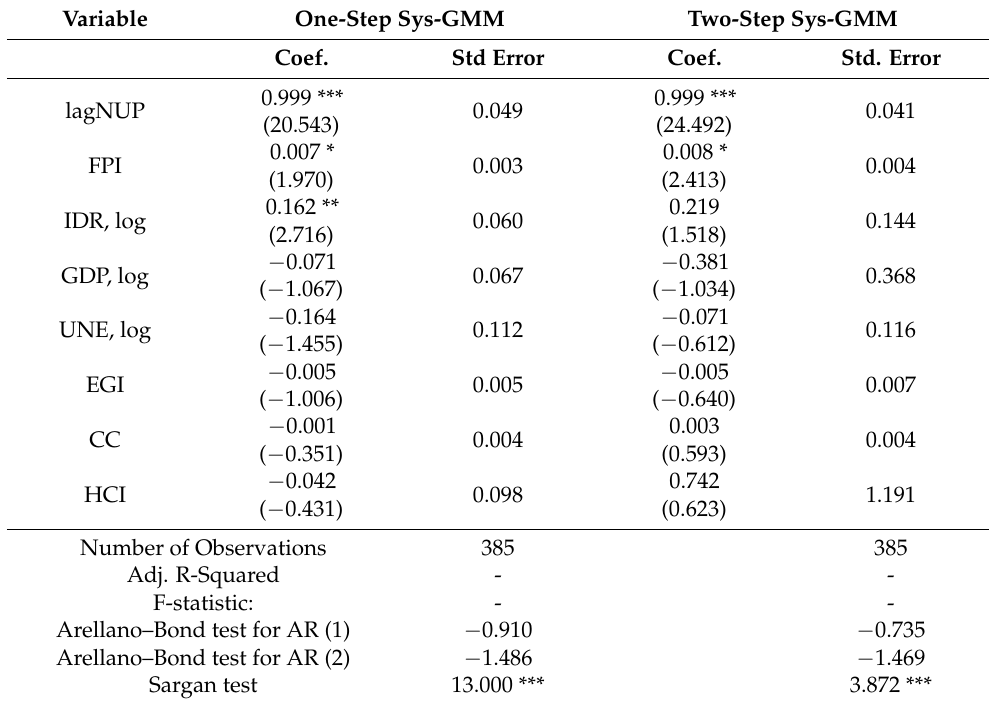
Table 5. Regression results of one and two-step sys-GMM estimations for LAC countries.